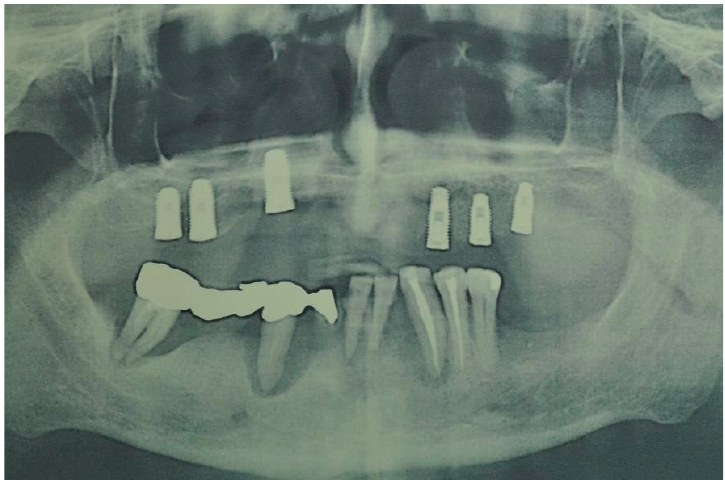
Figure 3. Postoperative orthopantomography in the upper arch.